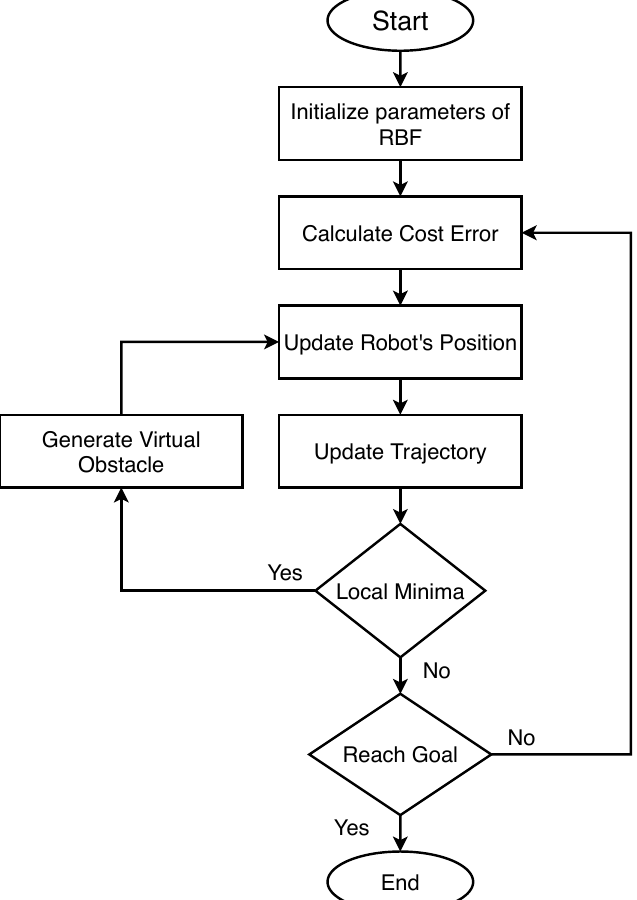
Figure 1. Flowchart of the proposed RBF